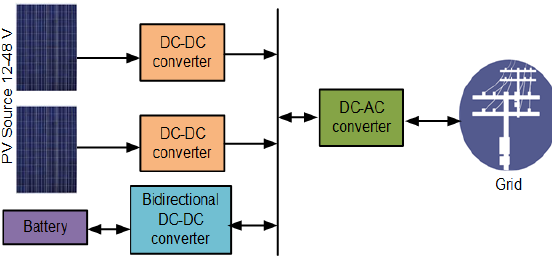
Figure 1. High gain DC ‒ DC converter in Microgrid system.